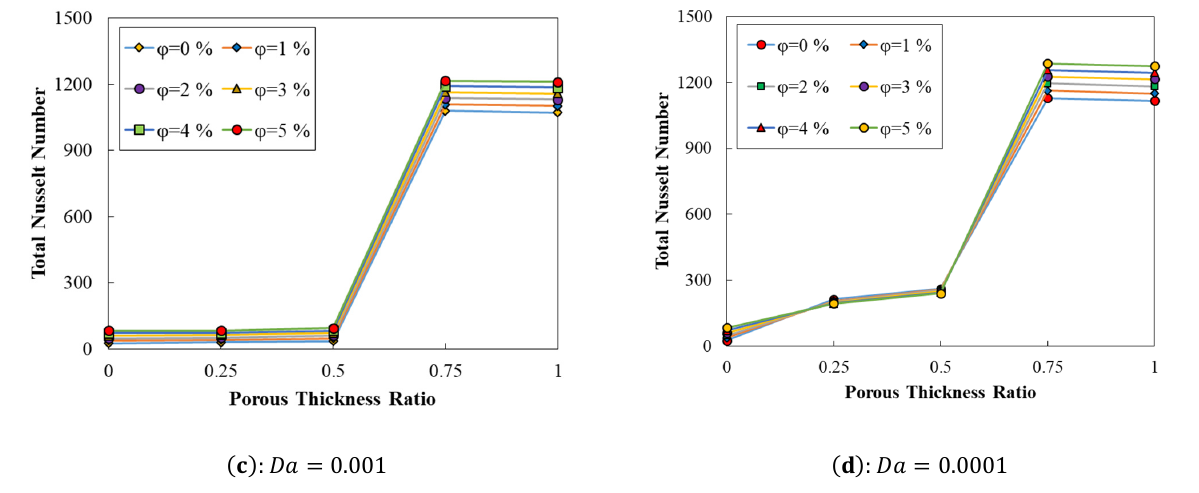
Figure 4. Total Nusselt number versus porous thickness ratio for diverse volume fractions at different Darcy numbers (case I).